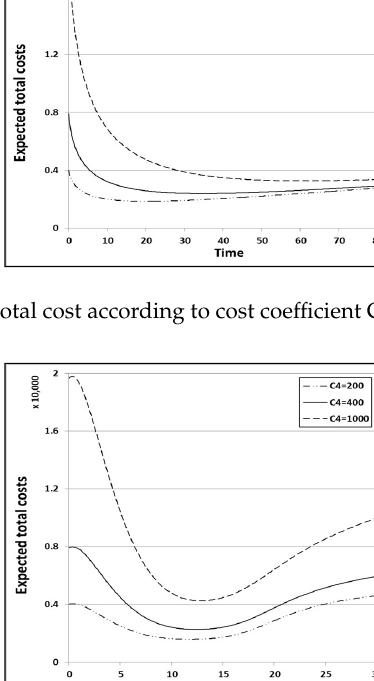
Figure 18. Expected total cost according to cost coefficient C 4 for the 3 rd condition.